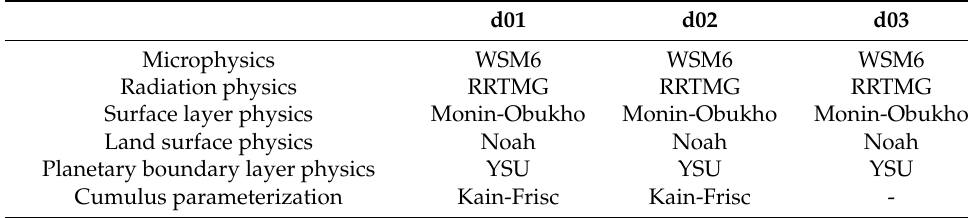
Table 2. Main physical parameterization schemes in the